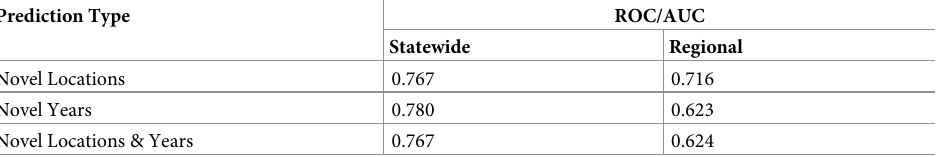
Table 3. Mean ROC/AUC across iterations of both statewide and regional models (averaged across all regions within California) in predicting fire probabilities in novel years, novel locations, and in novel years at novel loca- tions not used in model